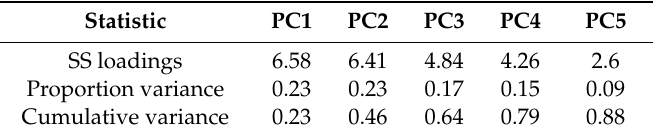
Table 3. Principal components (PC1–5) of the principal component analysis (PCA) conducted on all variables (RGB bands, RGB indices, texture indices and morphometric indices derived from the digital surface model (DSM), SS: sum of squares.